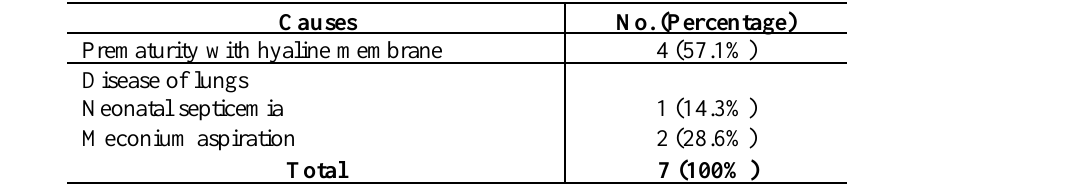
Table IV : Causes of Early Neonatal Death